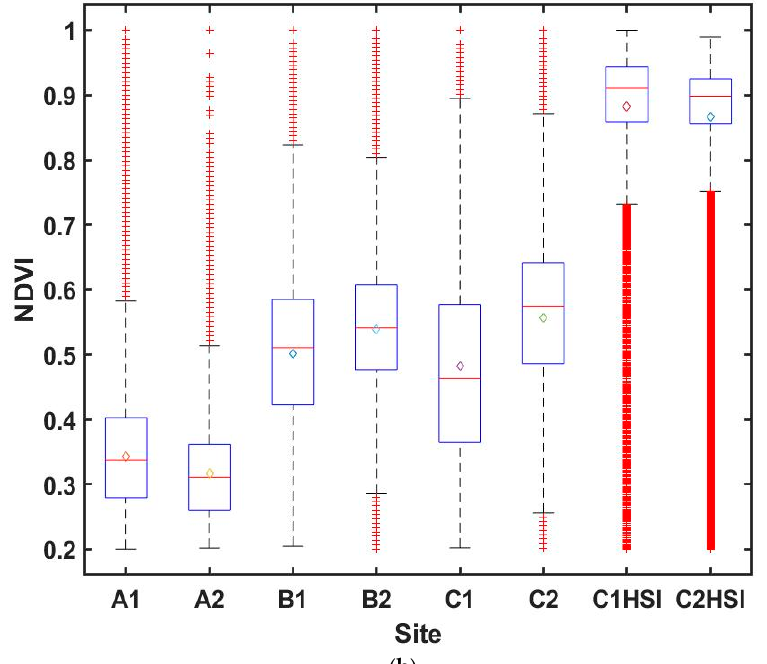
Figure 3. Box plots of the variables used for constructing the surface temperature against vegetation index (Ts-VI) spaces for all the sites. ( a ) Temperature; ( b ) normalized difference vegetation index (NDVI) (0.2–1.0). The bars on the box plots represent the distribution of the variables. The diamonds inside the boxes represent the mean values of the variables. The red marks beyond the short horizontal line are the outliers. According to the results of the Kolmogorov-Smirnov test ( p = 0 for all the sites), the temperature